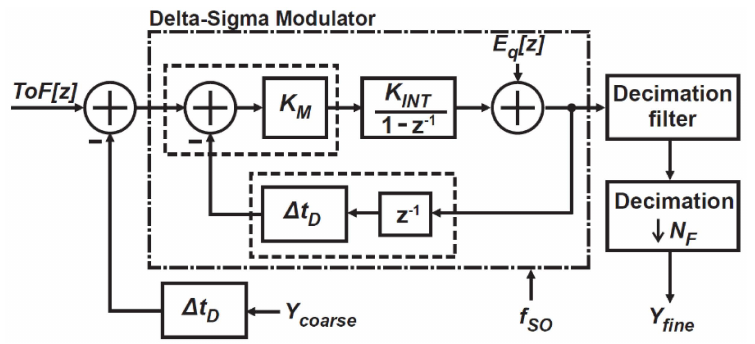
Figure 4. An equivalent block diagram for fine ToF